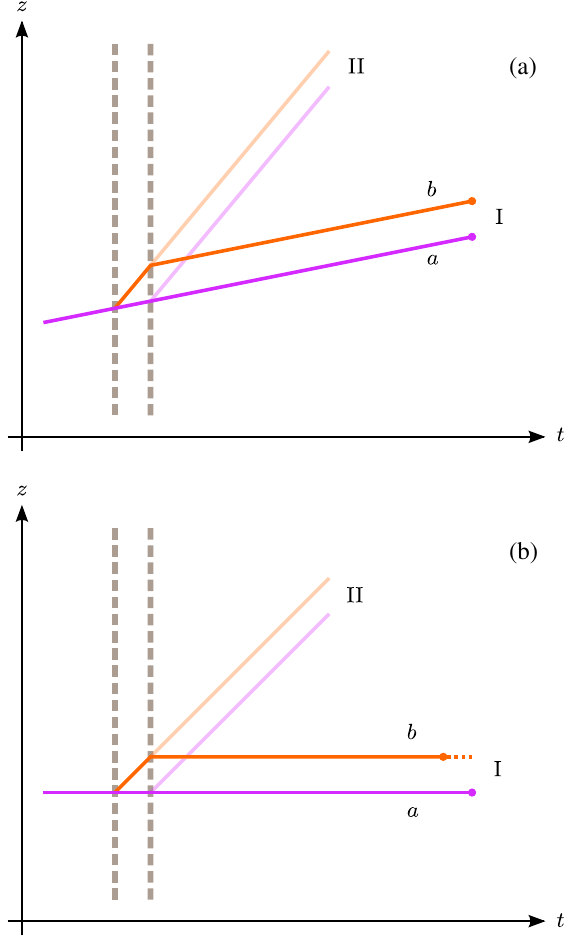
FIG. 13. Central trajectories at the exit port of an open interferometer. Simultaneous detection for nonvanishing central velocities (a) corresponds to nonsimultaneous spacetime events in the comoving frame, where the interfering wave packets are at rest (b). The resulting proper-time difference, corresponding to the dashed segment in panel (b), is exactly compensated by the nonvanishing separation phase δϕ in panel sep